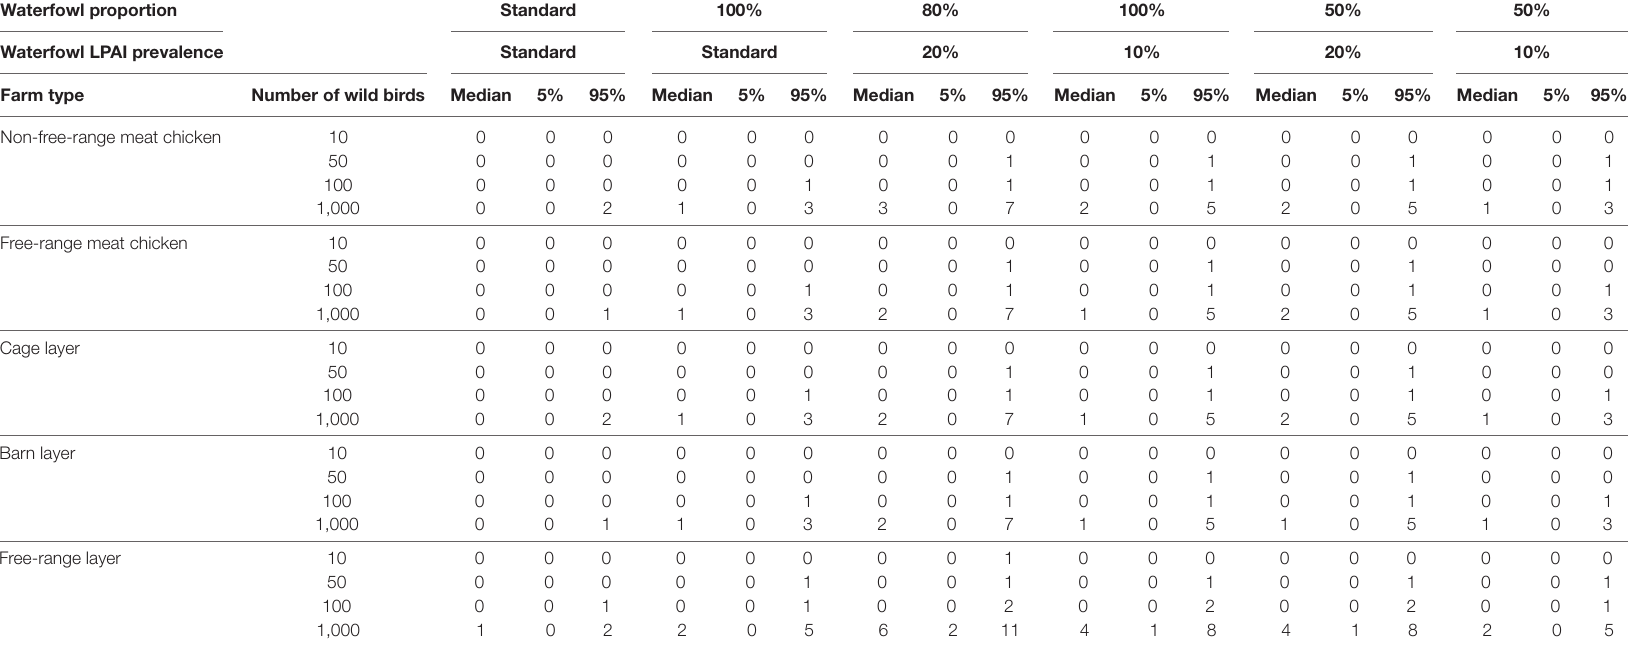
TaBle 7 | Number of low pathogenic avian influenza (LPAI) virus exposures that would occur given a number of wild birds ( n ) and changes in the overall probability of LPAI exposure ( p ) with changes in the proportion of wild birds on the farm that are waterfowl and the prevalence of LPAI in waterfowl for the commercial chicken farm types (non-free-range meat chicken, free-range meat chicken, cage layer, barn layer, free-range layer) at any point in time out of 100 scenarios (or farms) using binomial